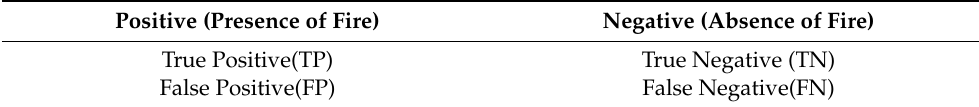
Table 2. Four possible outcomes of the vehicle detection.